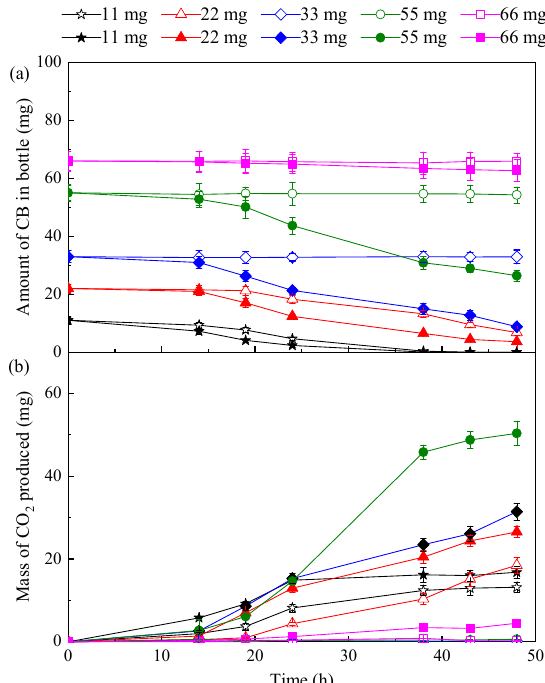
Figure 1. ( a ) Monochlorobenzene (CB) biodegradation and ( b ) CO 2 production profiles of the biphasic system (20% silicone oil, solid symbols) and single-phase system (empty symbols) under different CB dosages.